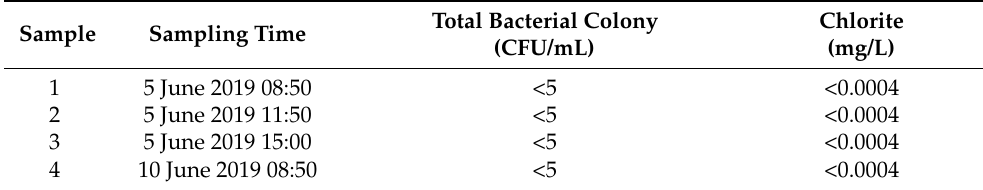
Table 4. Water quality in the dental